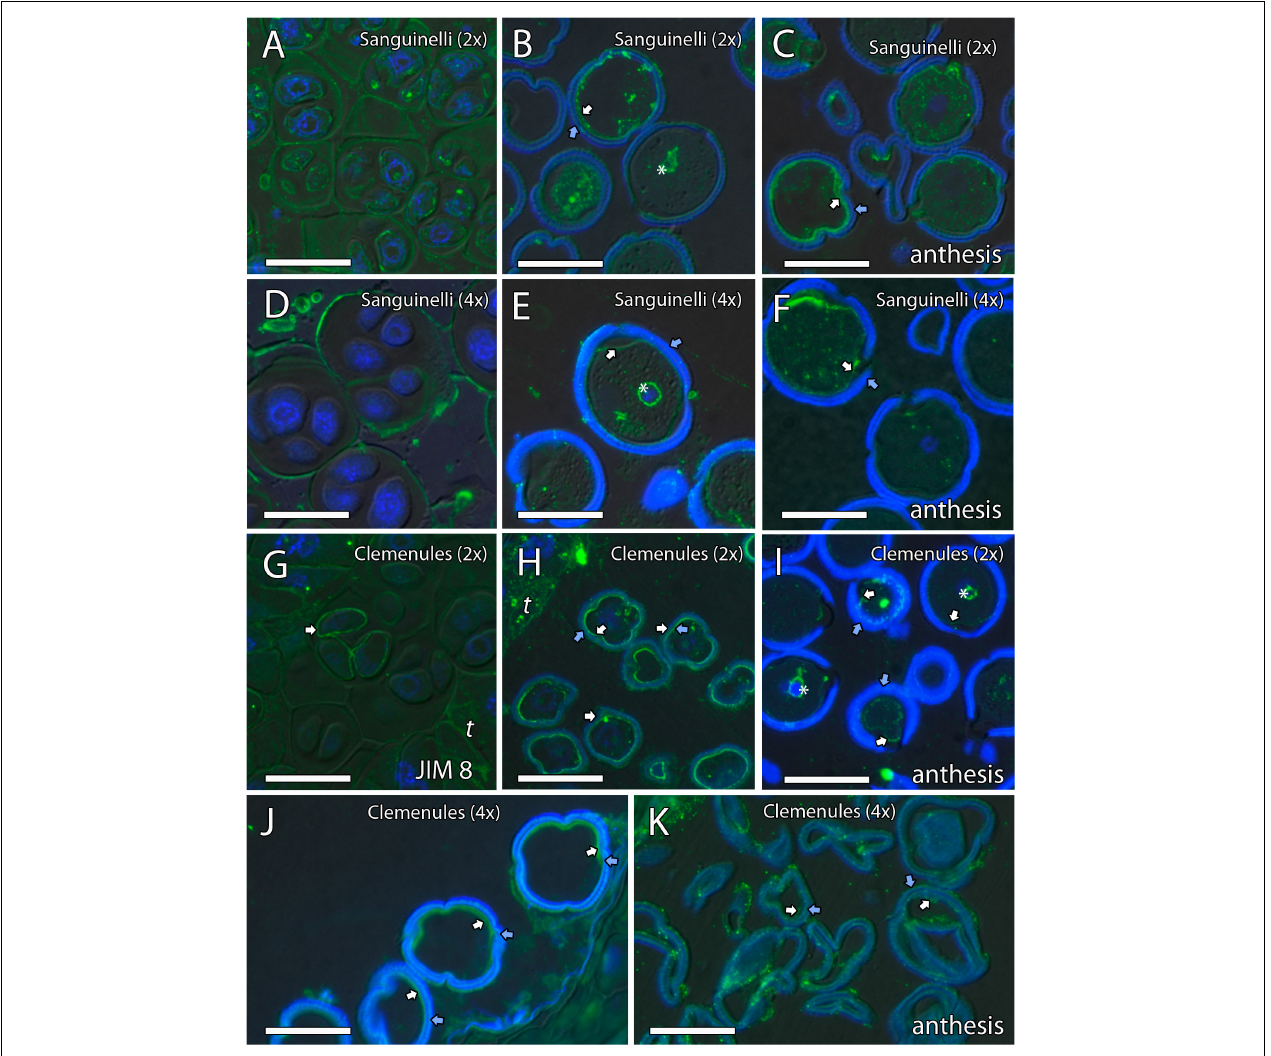
FIGURE 5 | Inmunolocalization of arabinogalactan proteins (AGPs) during pollen development in diploid and doubled diploid “Sanguinelli” blood orange and “Clemenules” clementine. Monoclonal antibody used: JIM8 against AGPs. (A,D) Tetrads that retained the wall of microspore mother cells (MiMCs) and reacted positively to JIM8 in (A) diploid and (D) doubled diploid ”Sanguinelli”. (B,E) Pollen grains showing JIM8-specific labeling in the intine (white arrow) and the wall of the generative nucleus (asterisk) after mitosis I and vacuolization in (B) diploid and (E) doubled diploid ”Sanguinelli”. (C,F) Mature pollen grains at anthesis with JIM8 partial reaction in the intine (white arrow) and cytoplasm in (C) diploid and (F) doubled diploid “Sanguinelli.” (G) Tetrads showing weak JIM8-specific labeling on the microspore cell wall (white arrow) in diploid “Clemenules”. (H,J) Individualized microspores where JIM8 reacted in the intine (white arrows) in (H) diploid and (J) doubled diploid “Clemenules”. (I,K) Mature pollen grains showing weak JIM8 reaction in the intine (white arrows) of the pollen grains at anthesis in (I) diploid and (K) doubled diploid "Clemenules”. (I) Wall of the generative nuclei (asterisks) reacted to JIM8 in diploid “Clemenules”. The exine is shown in blue (autofluorescence, blue arrows). All scale bars = 25 µ m. Tapetum (t), diploid (2x), and doubled diploid